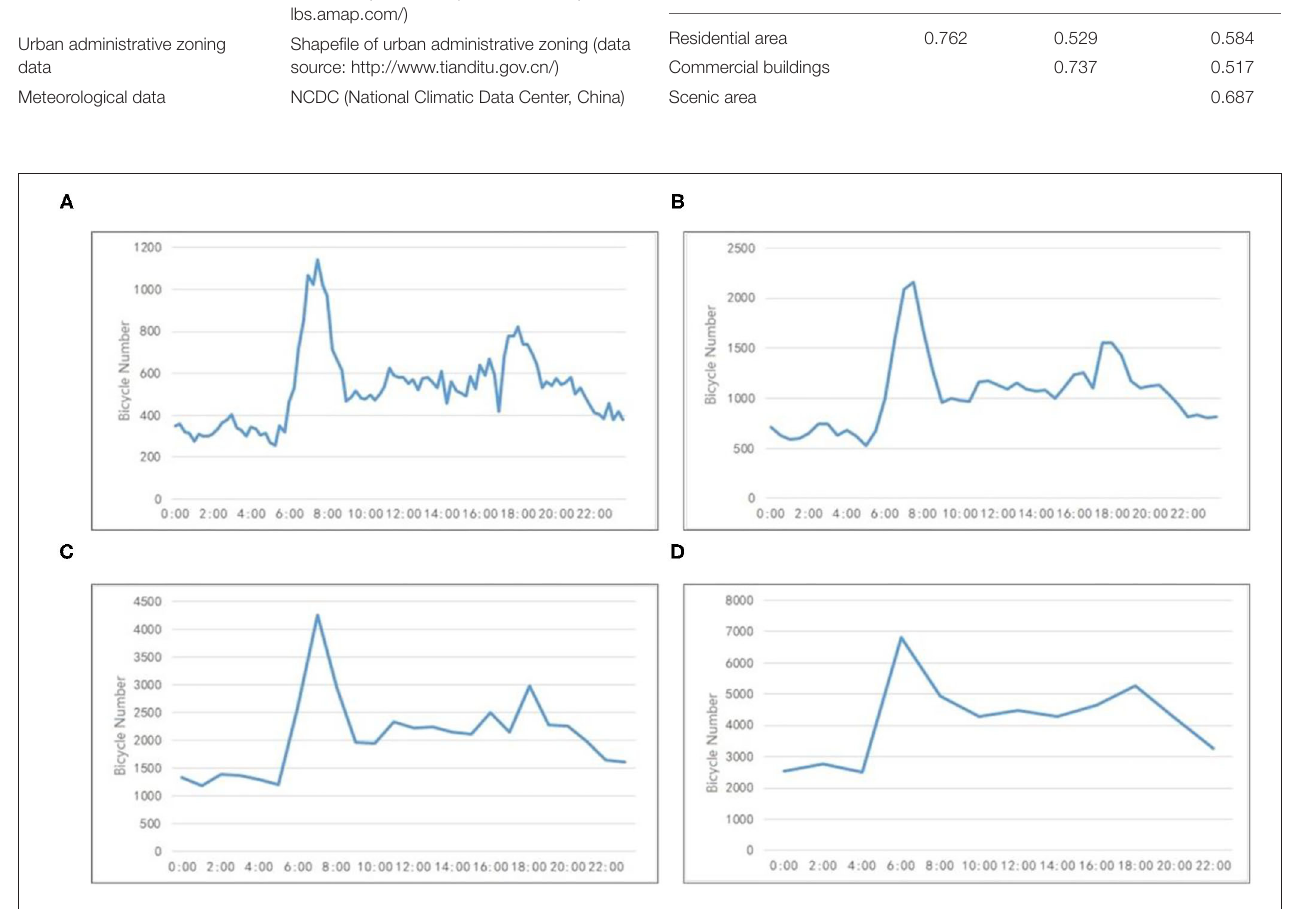
FIGURE 2 | The curves of bicycle numbers at different intervals. (A) 15min. (B) 30min. (C) 60 min. (D) 120min.